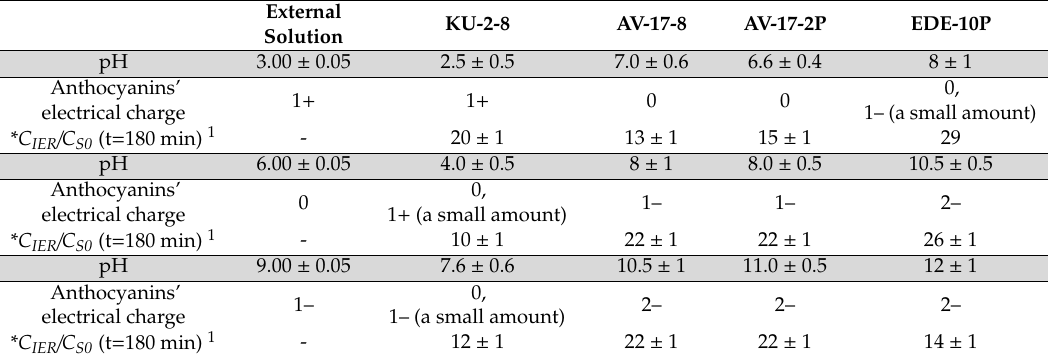
Table 3. Some characteristics of the systems under